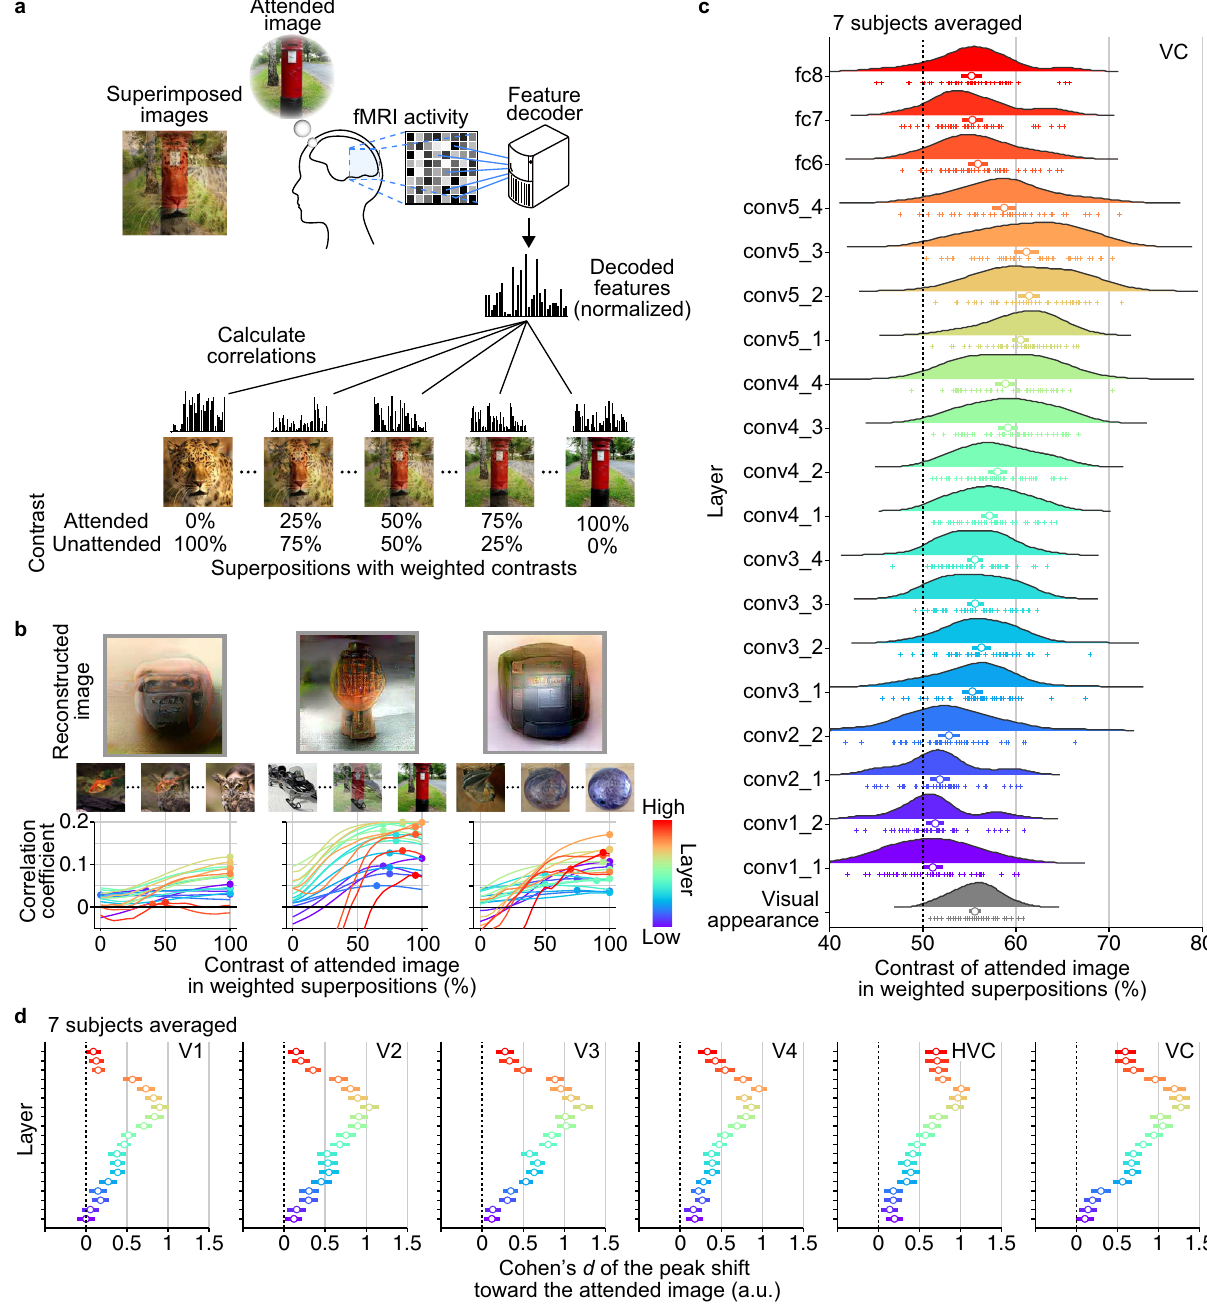
Fig. 3 Attentional modulation modeled by image contrast. a Evaluation procedure by weighted image contrasts. Correlations were calculated between decoded feature patterns and feature patterns computed from superpositions with weighted contrasts (5% steps; presented stimuli correspond to 50% contrast; normalized by the values in training images for each unit; see Methods: “ Evaluation of attentional modulation by weighted image contrast ” ). b Correlation curves as a function of contrast for individual reconstructions with relatively high rating accuracies (decoded from VC). Circles indicate the contrasts with the highest correlations for each of 19 DNN layers denoted by colors. c Distributions of peak contrasts for each DNN layer (decoded from VC; averaged across subjects). The peak contrasts for 45 image pairs (cross markers) are shown with density plots (horizontal bars, 95% C.I.). The gray distribution at the bottom indicates contrasts of visual appearance evaluated in an independent behavioral experiment (averaged across subjects; see Methods: “ Evaluation of visual appearance ” ). d Peak shifts at visual subareas (averaged across subjects). The effect sizes (Cohen ’ s d ) of the peak shifts (difference from 50%) are shown with 95% C.I. for each area and layer. See Supplementary Fig. 3 for the results of individual and 17 layers out of 19 layers for Subject 1 – 7, respectively stimulus contrasts after the attention period. The matched (Supplementary Fig. 3; one-sided t -test, p < 0.01, Bonferroni contrasts (indicated by “ visual appearance ” in Fig. 3c) were correction by the number of DNN layers). In an independent comparable to the biases observed in the decoded features (55.6%, fi ve subjects averaged; see Methods: “ Evaluation of visual behavioral experiment, we measured the perceived contrasts of equally-weighted stimuli under attention by matching the appearance ” ).